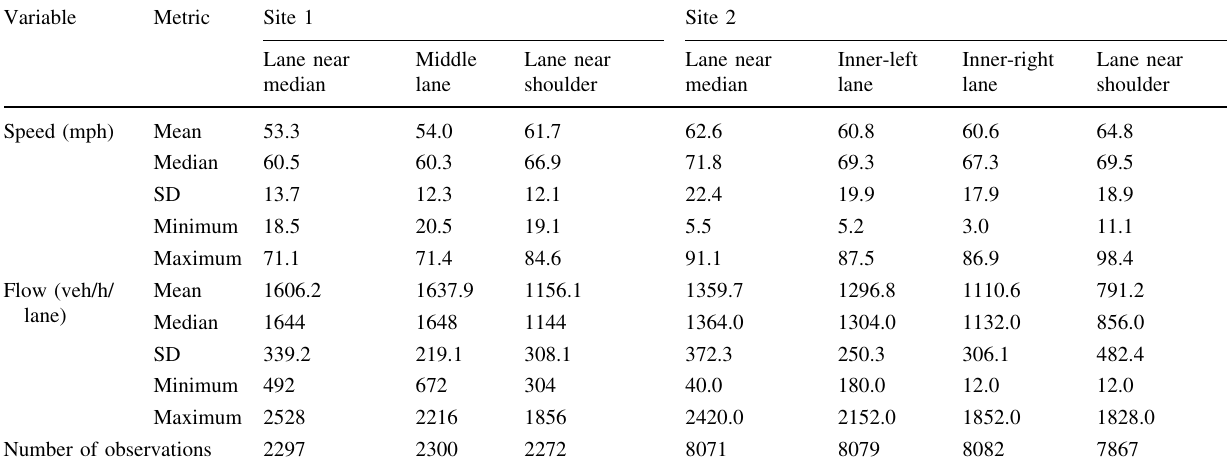
Table 1 Descriptive statistics of flow parameters during the peak period